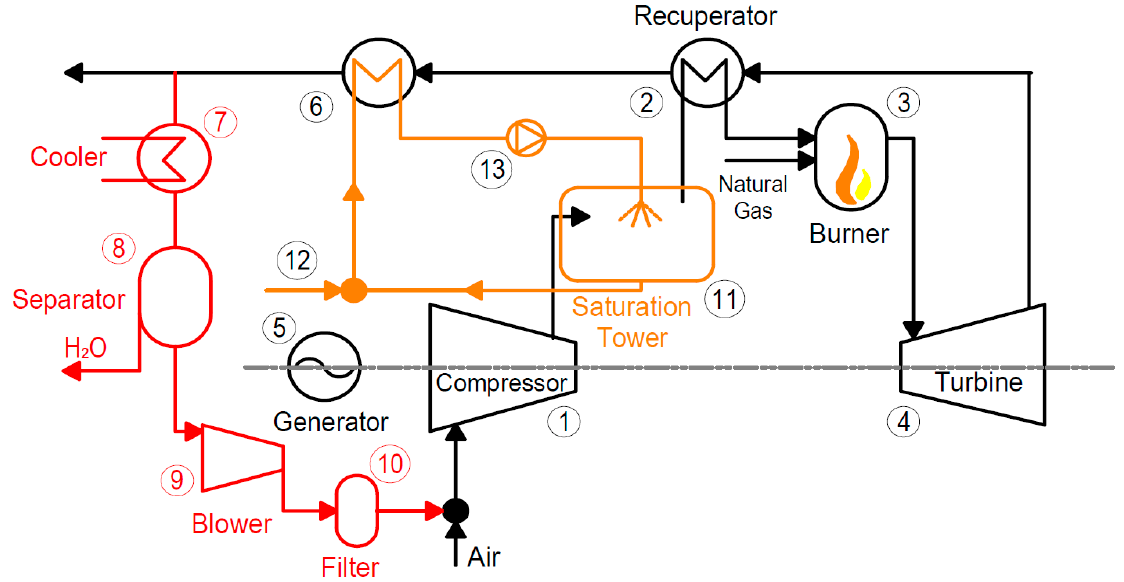
Figure 5. The REVAP cycle, combining liquid water injection with aftercooling and feedwater preheat with economizer 2 (adapted from [75]).